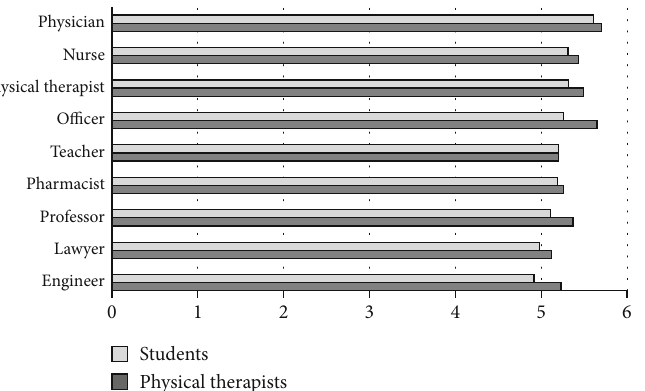
Figure 5: Mean ranks for level of usefulness.